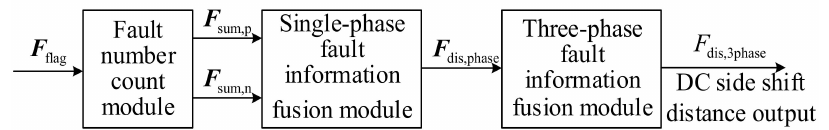
Figure 5. The implementation process of neutral point DC side shift